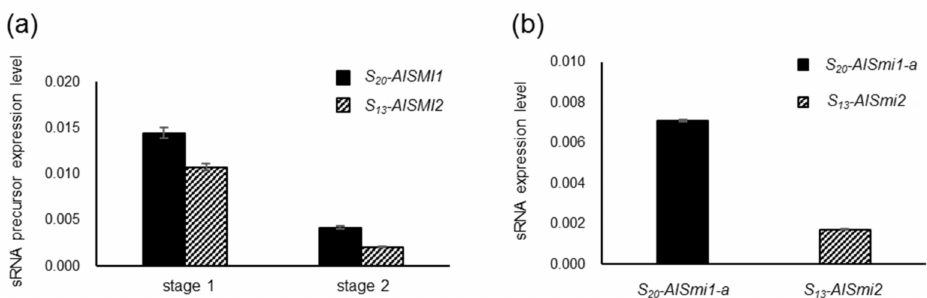
Figure 5. Accumulation of sRNA precursors and a 24-nt sRNA in early stage anthers of S 20 S 13 heterozygotes. ( a ) RT-qPCR of S 13 -AlSMI2 and S 20 -AlSMI1 precursors at stages 1 and 2 in S 20 S 13 heterozygotes. GAPDH was used as an endogenous reference gene. The results shown are means ± s.d. of 3 replicates. ( b ) Quantification of S 13 -AlSmi2 and S 20 -AlSmi1 in mixtures of stage 1 and 2 anthers in S 20 S 13 heterozygotes via stem-loop RT-PCR analysis. miR166 was used as an endogenous reference gene. The results shown are means ± s.d. of 3